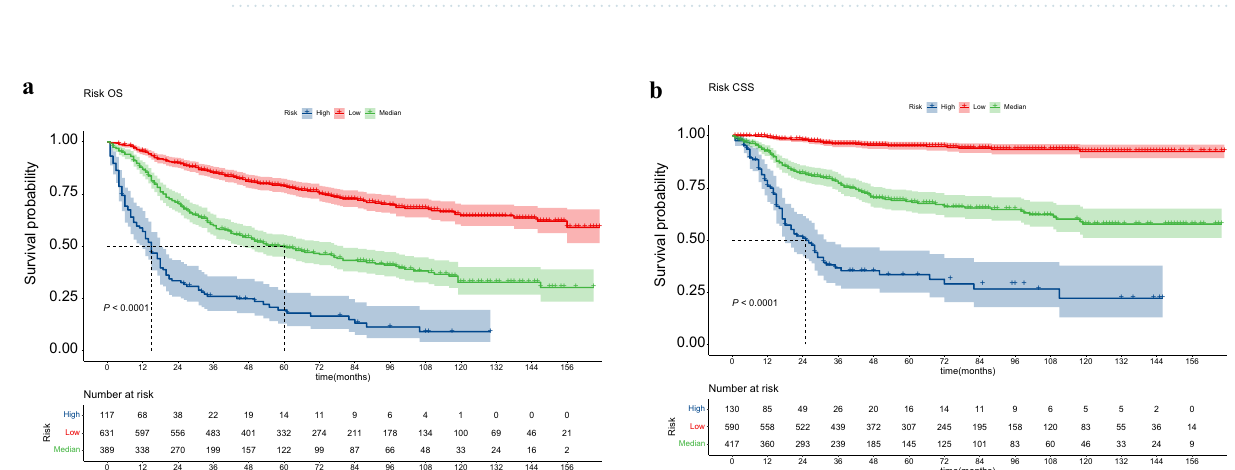
Figure 4. Risk subgroup analysis of OS ( a ) and CSS ( b ) using the Kaplan ‒ Meier